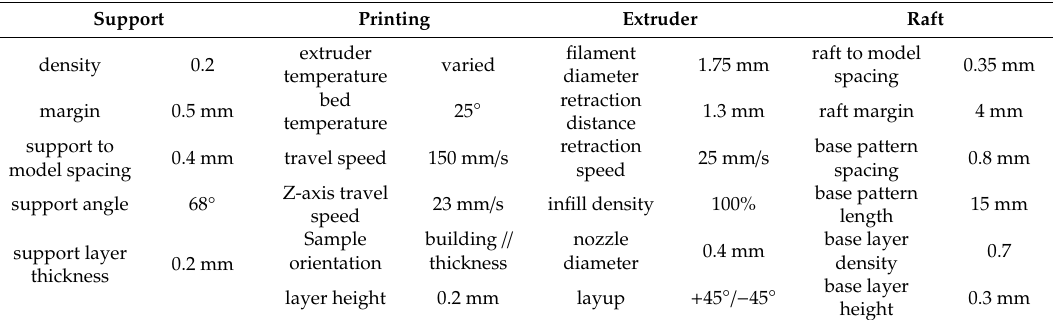
Table 1. Printing parameters used in this